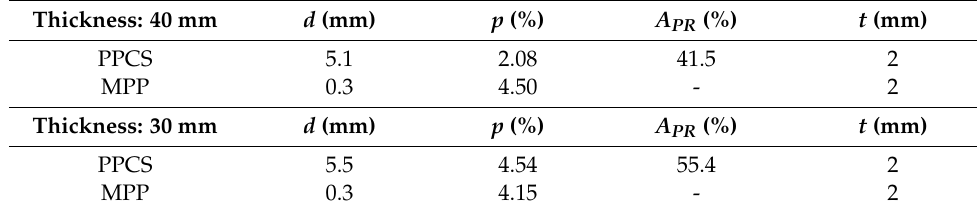
Table 2. Optimized parameters of PPCS and MPP.